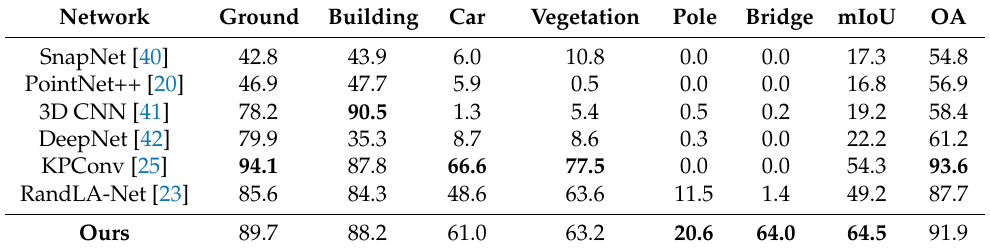
Table 3. Segmentation results evaluated on IoU of each category, mIoU, and OA in scene-2 of CSPC.